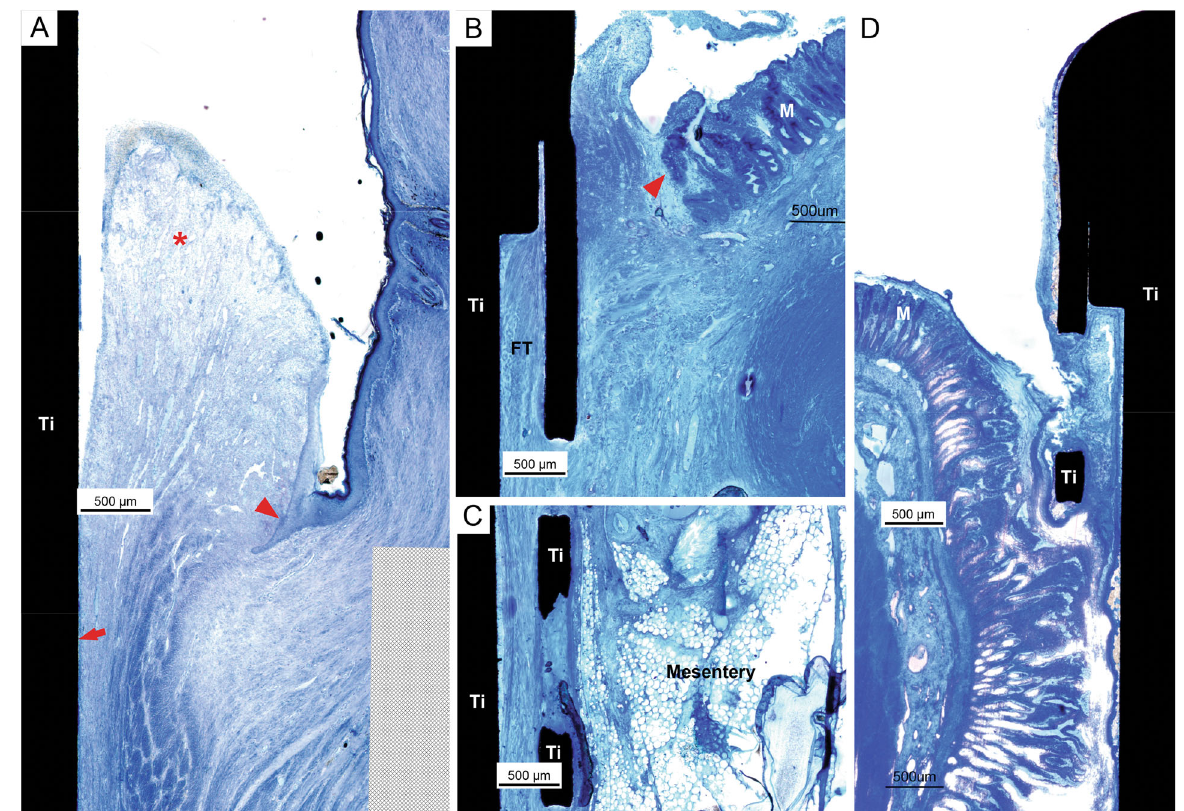
Fig. 4 A Light micrographs of the skin-penetrating outer portion of the implant (EBM12, 9 weeks). The keratinised skin ends at a distance from the implant surface (red arrowhead). The space between the epidermis and the implant was fi lled by granulation tissue with mod- erate in fi ltration of in fl ammatory cells (red asterisk). At the junction between the soft tissue and the implant (red arrow), dense connective tissue parallel to the implant was well adapted to the material surface. B – D Light micrographs showing the integration between the intestine and the inner mesh and cylindrical surface of the titanium port in a urostomy model (EBM13, 14 weeks). B On the mesenteric side, integration was observed between the external part of the intestine and